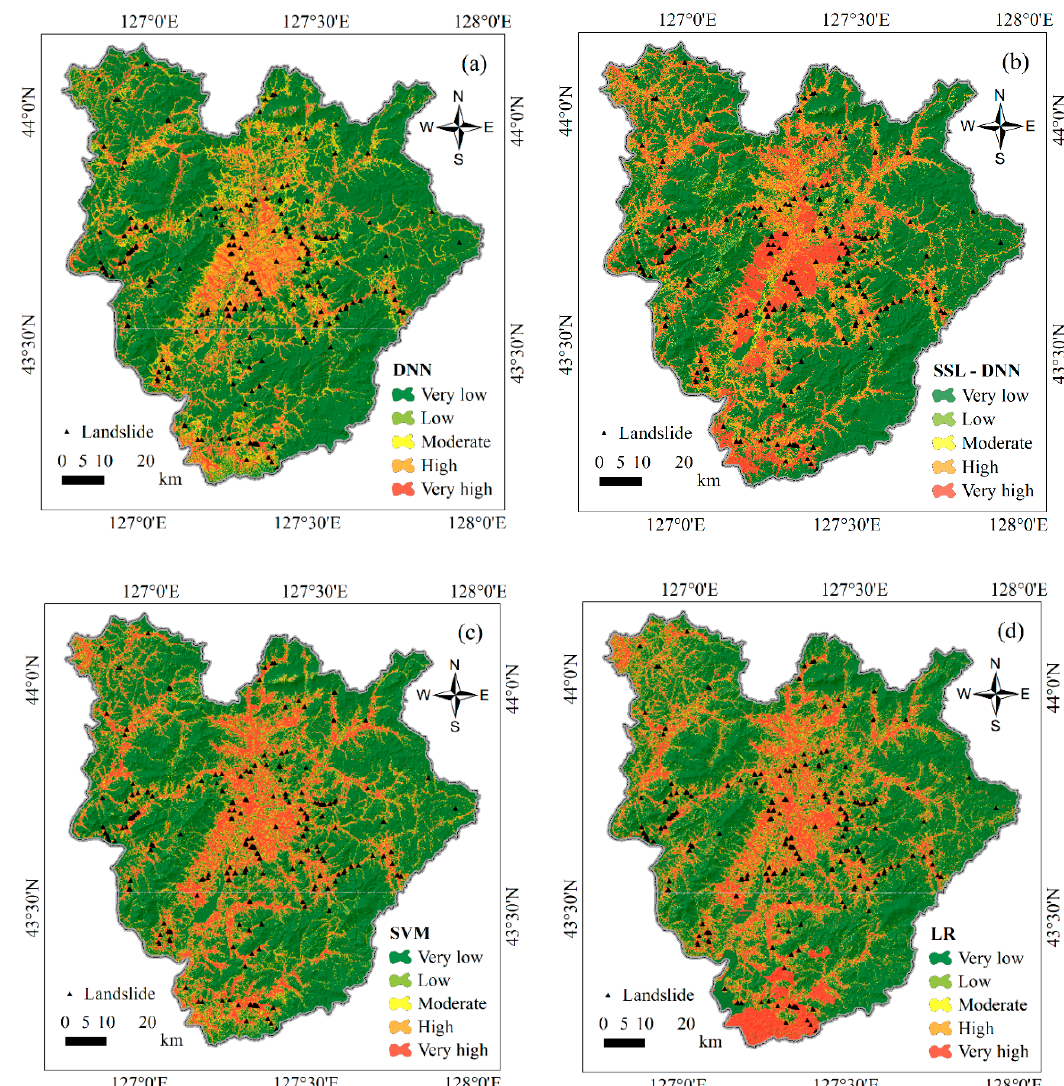
Figure 10. Landslide susceptibility maps. ( a ) DNN, ( b ) SSL-DNN, ( c ) SVM, ( d ) LR.